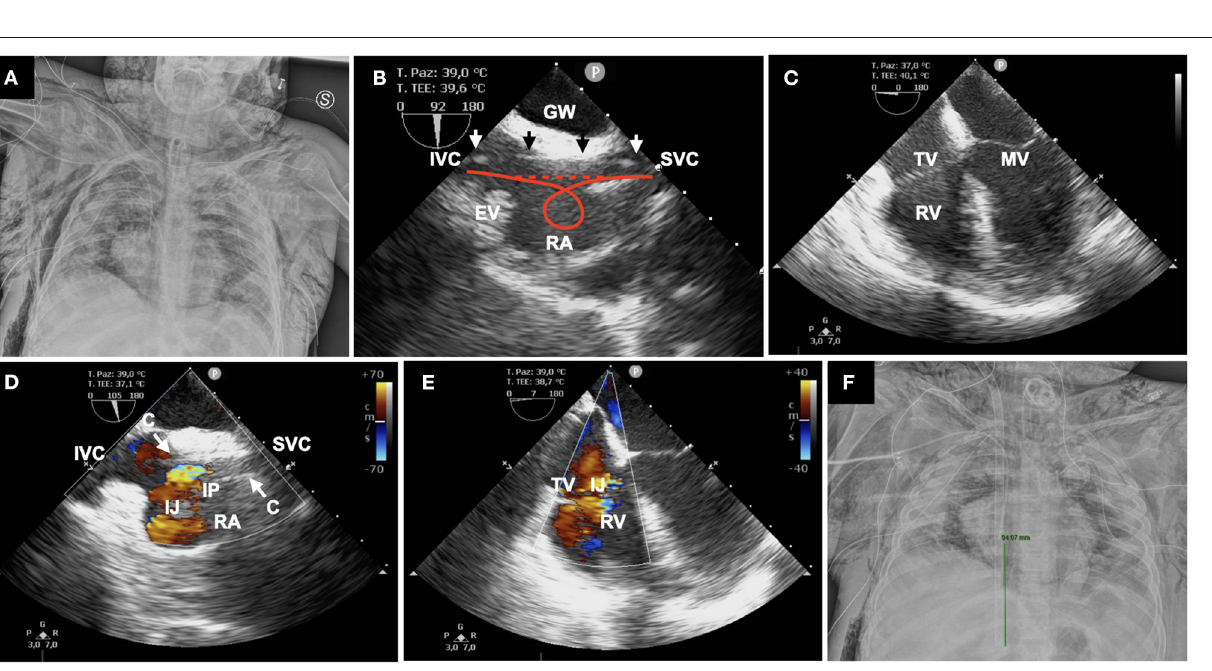
FIGURE 1 | (A) Massive air leak syndrome with pneumomediastinum, bilateral pneumothorax, and subcutaneous emphysema. (B) GW (arrows) displayed straight from the SVC to IVC; the red lines show how a discontinuous hyperechoic image can help in ruling out looping; right atrium (RA), Eustachian valve (EV). (C) Absence of looping or GW malposition in the right ventricle (RV) is demonstrated in four-chamber MEV; tricuspid valve (TV), mitral valve (MV). (D) Mid-esophageal bicaval view showing the correct position of the cannula (C) with the infusion port (IP) in the middle of the right atrium; infusion jet (IJ). (E) Four-chamber MEV confirming the direction of the IJ toward the tricuspid valve. (F) Chest X-ray demonstrating the correct position of the cannula; the green line measures the tip-to-IP distance (9.4